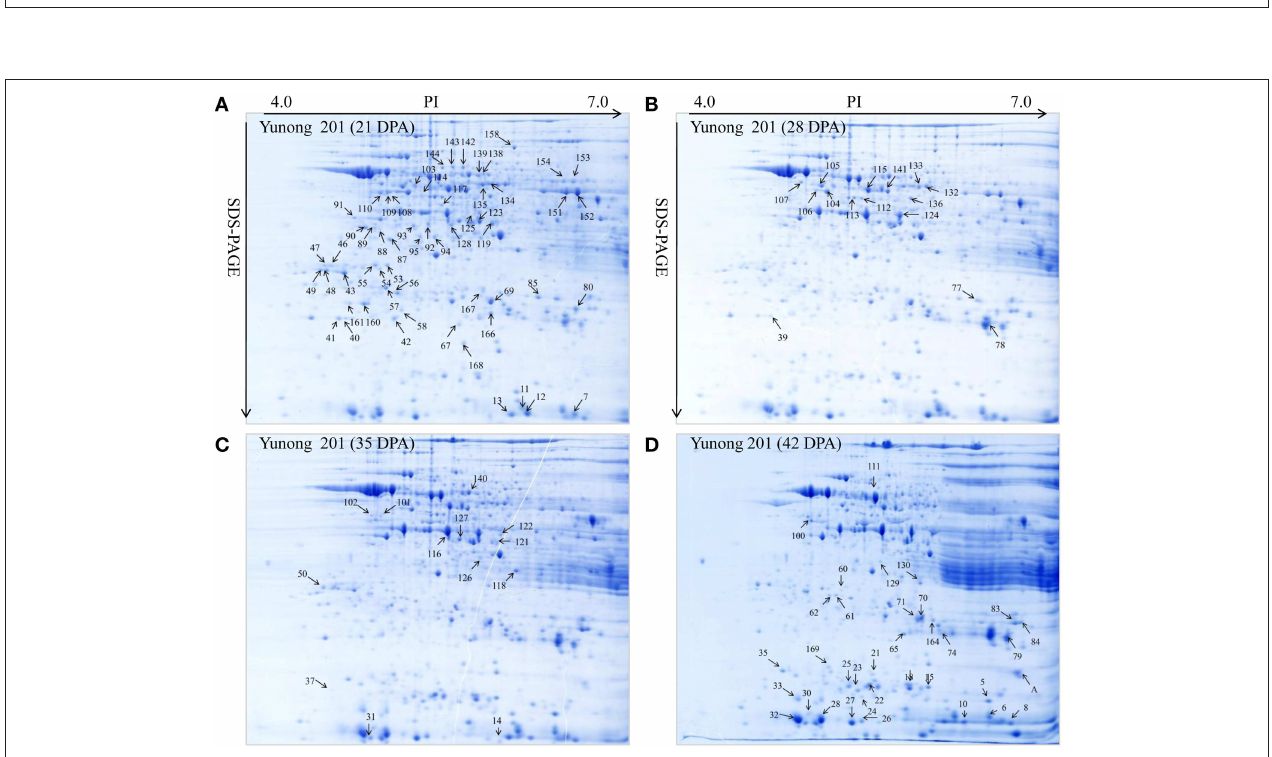
FIGURE 3 | Showing Yunong 201 at four stages of grain development. (A–D) 2-DE maps during four grain development stages for 21, 28, 35, and 42 DPA in Yunong 201.